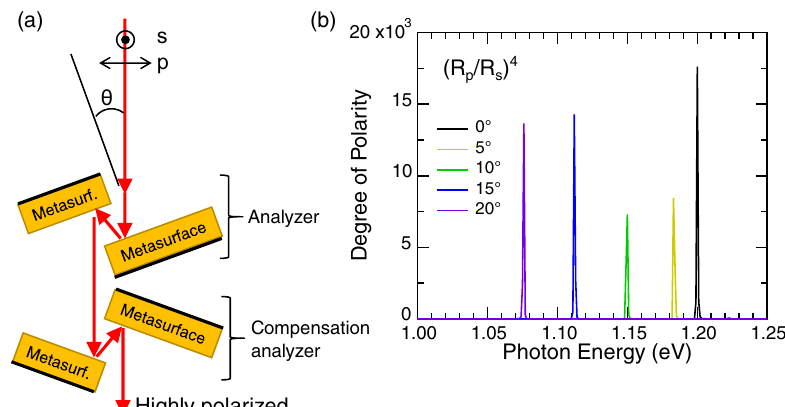
Figure 5. ( a ) Schematic of a compact, high-throughput, on-axis spectroscopic analyzer, composed of the pairs of metasurfaces in Figure 3c; ( b ) degree of polarity by the spectroscopic analyzer in ( a ), which is equal to a ratio of ( R p /R s ) 4 . The incident angle θ in ( a ) varies from 0 ◦ to 20 ◦ by rotating the